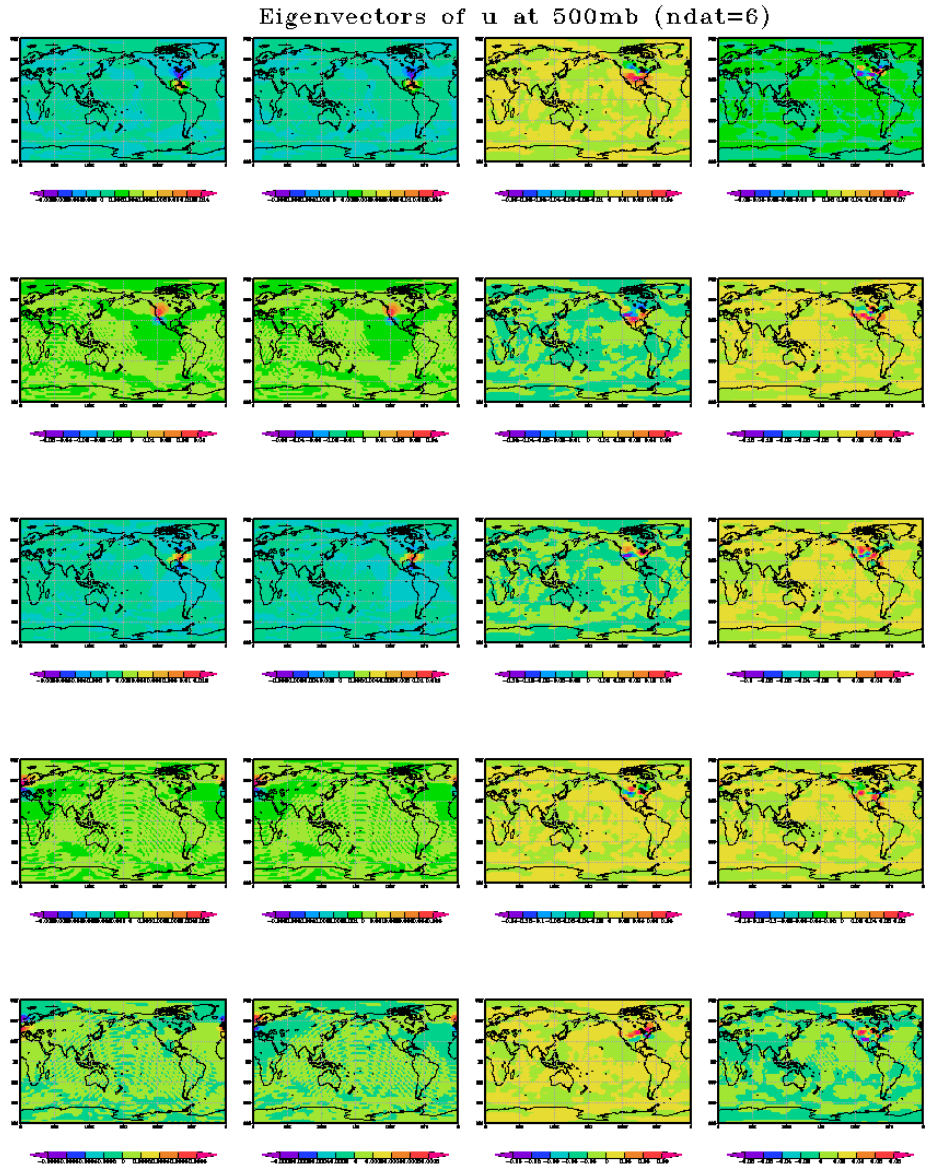
Fig. 4. The same as Fig. 3, but for u